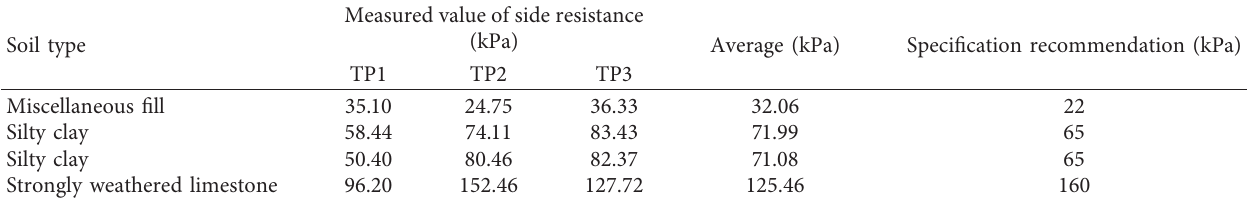
Table 5: Comparison between measured side friction resistance of each soil layer and recommended values.